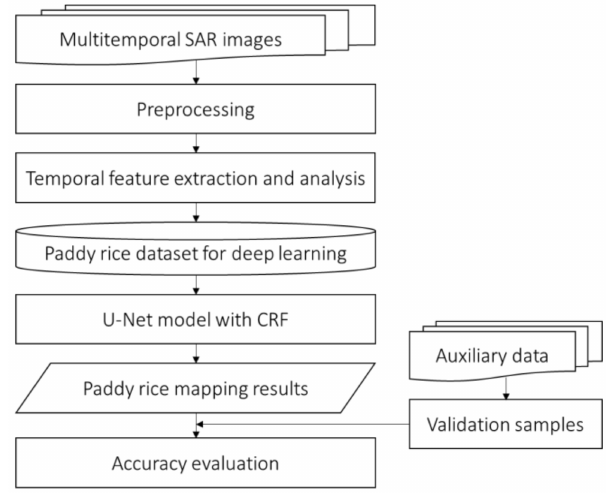
Figure 5. Flow chart of the proposed paddy rice mapping method.